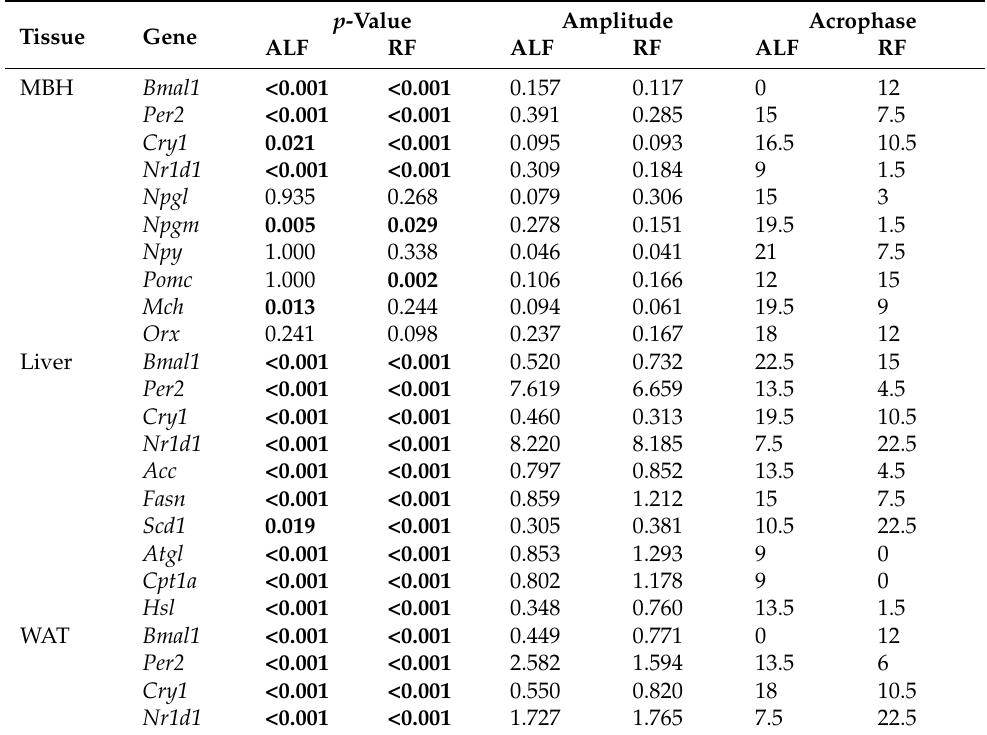
Table 2. Results of JTK-Cycle analyses on rhythmicity of mRNA expression. Bold font indicates statistical